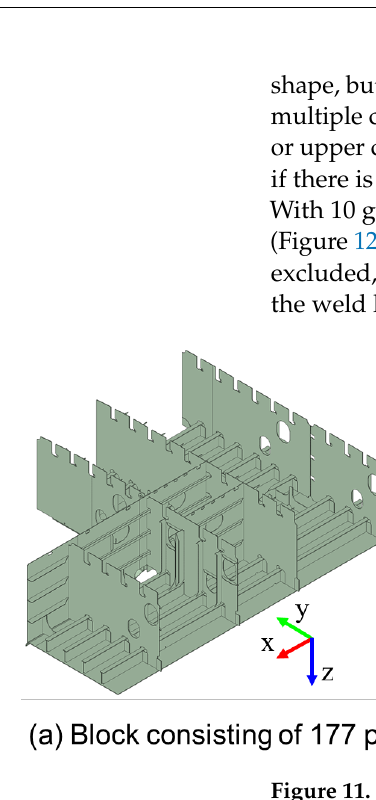
Figure 11. Part type classification for a block.